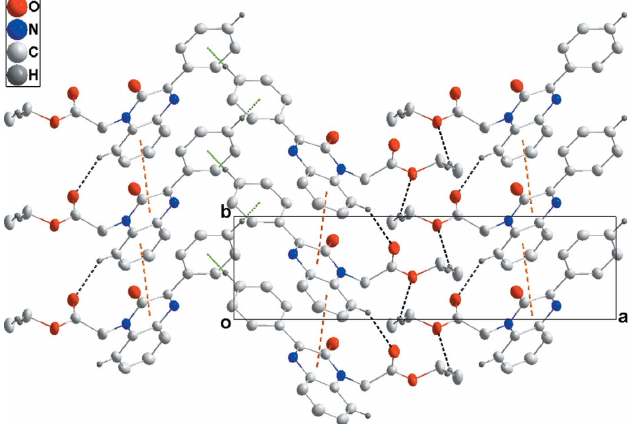
Figure 2 Detail of the intermolecular interactions viewed along the c -axis direction. C—H (cid:2)(cid:2)(cid:2) O hydrogen bonds are shown by black dashed lines while C—H (cid:2)(cid:2)(cid:2) (cid:2) (ring) and (cid:2) – (cid:2) -stacking interactions are shown, respec- tively, by green and orange dashed lines.